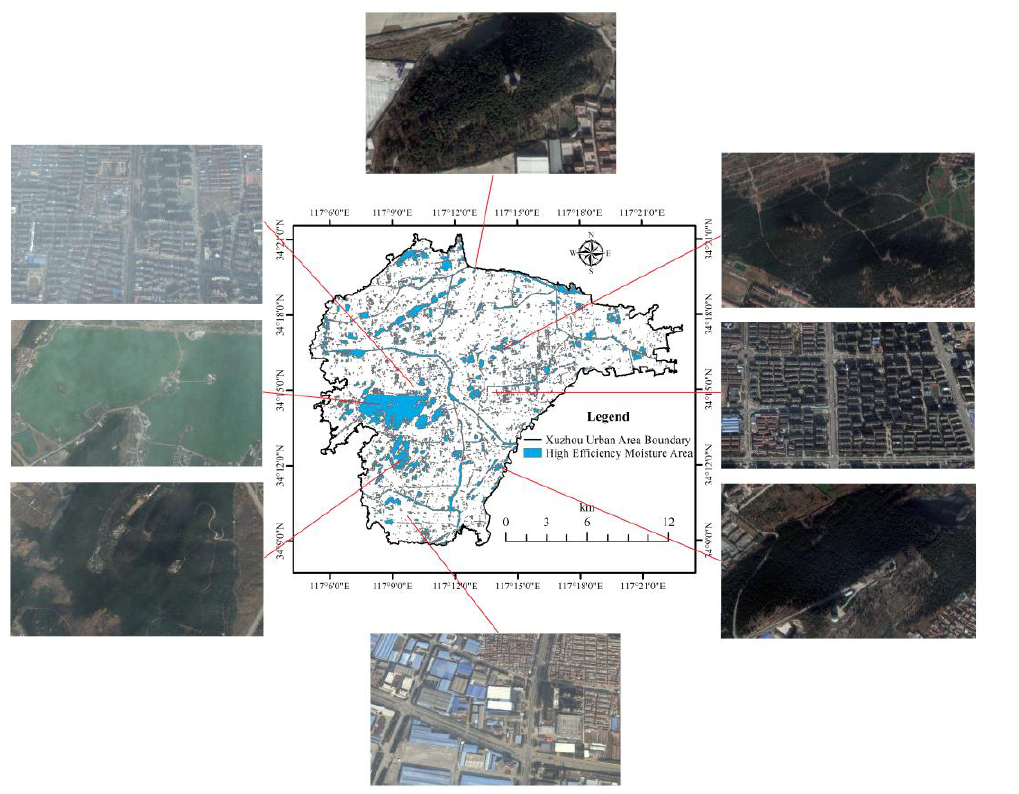
Figure 5. Typical areas of “High Efficiency Moisture Areas” and other areas. The pictures were extracted from Google Earth, and the pictures were taken on 14 December